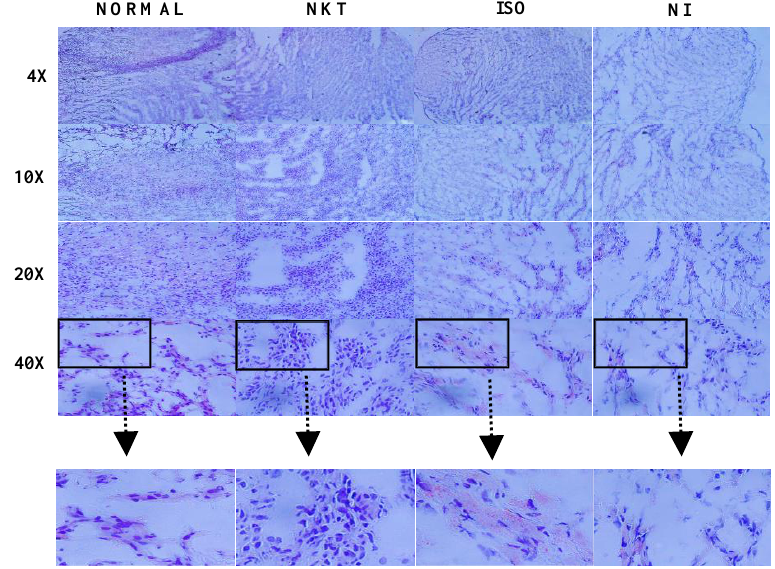
Figure 9. Effect of NKT on lipid accumulation in the myocardium (Oil red O staining). Normal control rat’s heart revealing normal myocardial architecture without lipid accumulation; NKT alone-treated rat’s heart also showing normal intact architecture of myocardium without lipid accumulation; ISO-induced rat’s heart showing extensive lipid accumulation compared to normal control rats; NKT-treated ISO-induced MI in rat’s heart showing reduced lipid accumulation compared to ISO-induced rats.